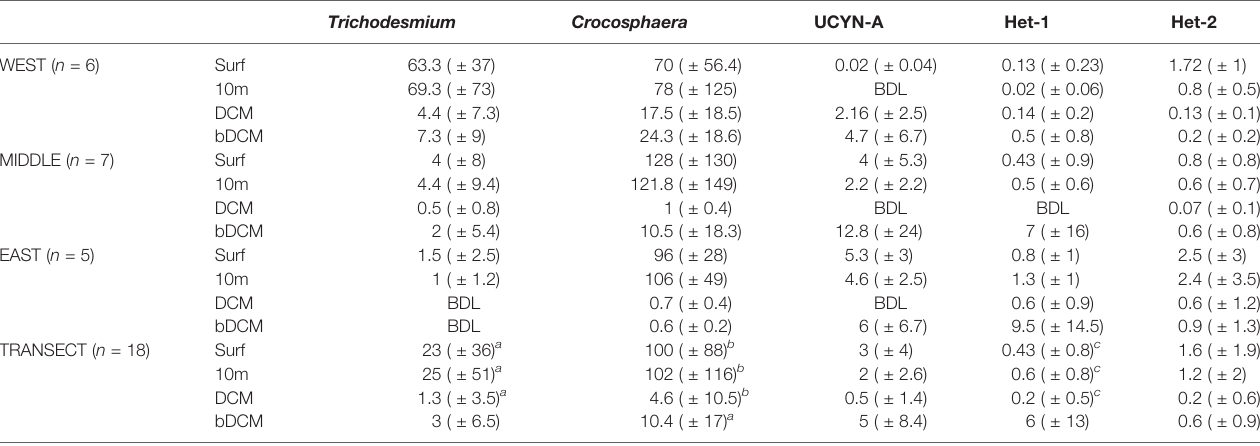
TABLE 1 | The nifH abundances (× 10 3 copies L-1 ± standard deviation) for each nitrogen- fi xing phylotype ( Trichodesmium , Crocosphaera , UCYN-A, Het-1 and Het-2). Trichodesmium Crocosphaera UCYN-A Het-1 Het-2 WEST ( n = 6)